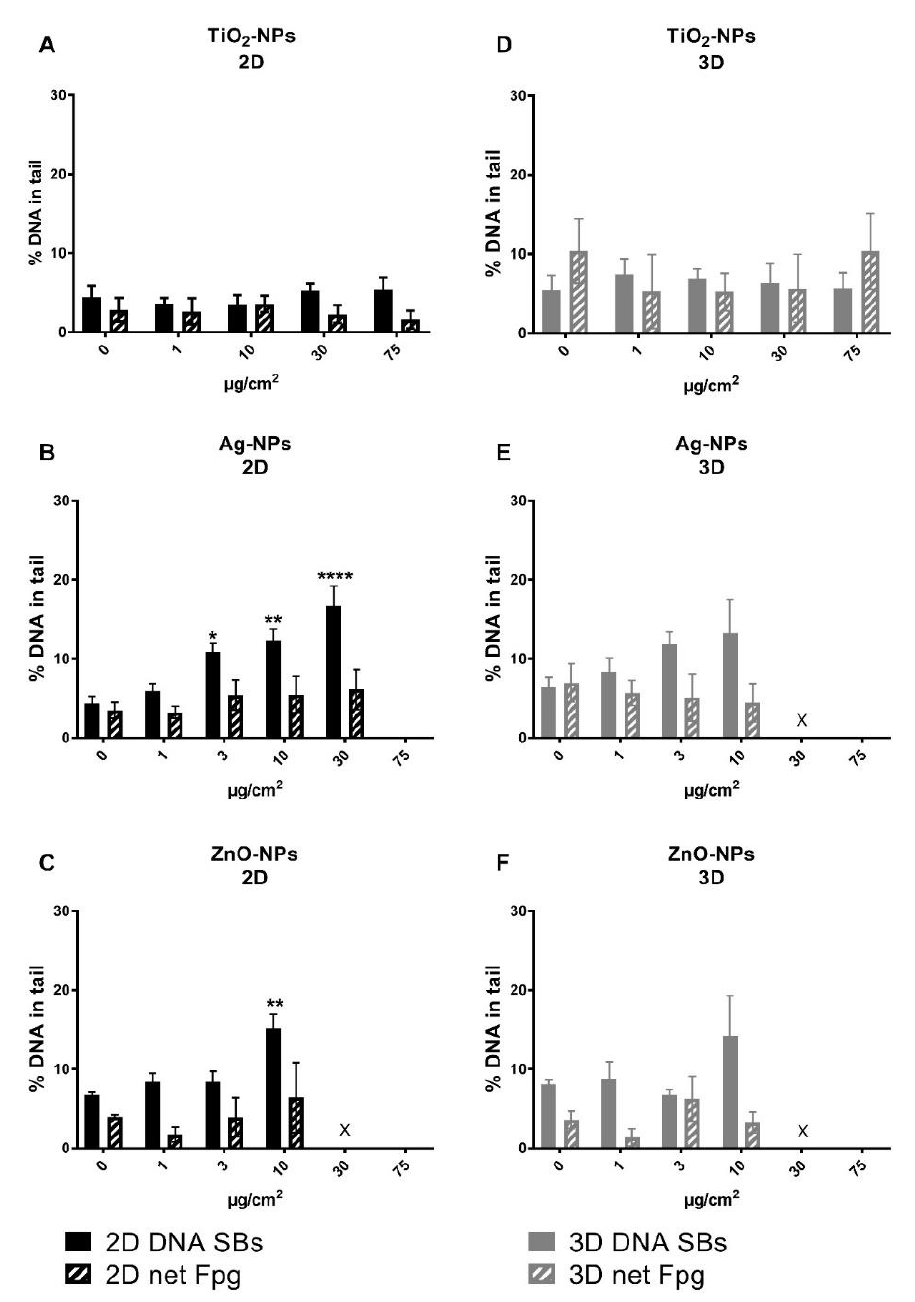
Figure 5. DNA damage in 2D and 3D cultures after exposure to TiO 2 -, Ag- and ZnO-NPs measured by the comet assay. The 2D ( A – C ) and 3D ( D – F ) cultures were exposed to TiO 2 -, Ag- and ZnO-NPs for 24 h. No increase in DNA damage was seen after exposure to TiO 2 -NPs. Ag- and ZnO-NPs induced an increase in DNA SBs; however, this was statistically significant only at cytotoxic concentrations. Moreover, n = 3 for TiO 2 - and ZnO-NPs, and n = 6 for Ag-NPs except at 3 µ g / cm 2 , where n = 4. X: not measured due to cytotoxicity and too low cell number. The concentration 75 µ g / cm 2 was excluded in the experiments with Ag-NPs and ZnO-NPs ( B , C and E , F ) because of high cytotoxicity in previously published experiments [36]. * p < 0.05, ** p < 0.01, *** p < 0.001 and **** p <